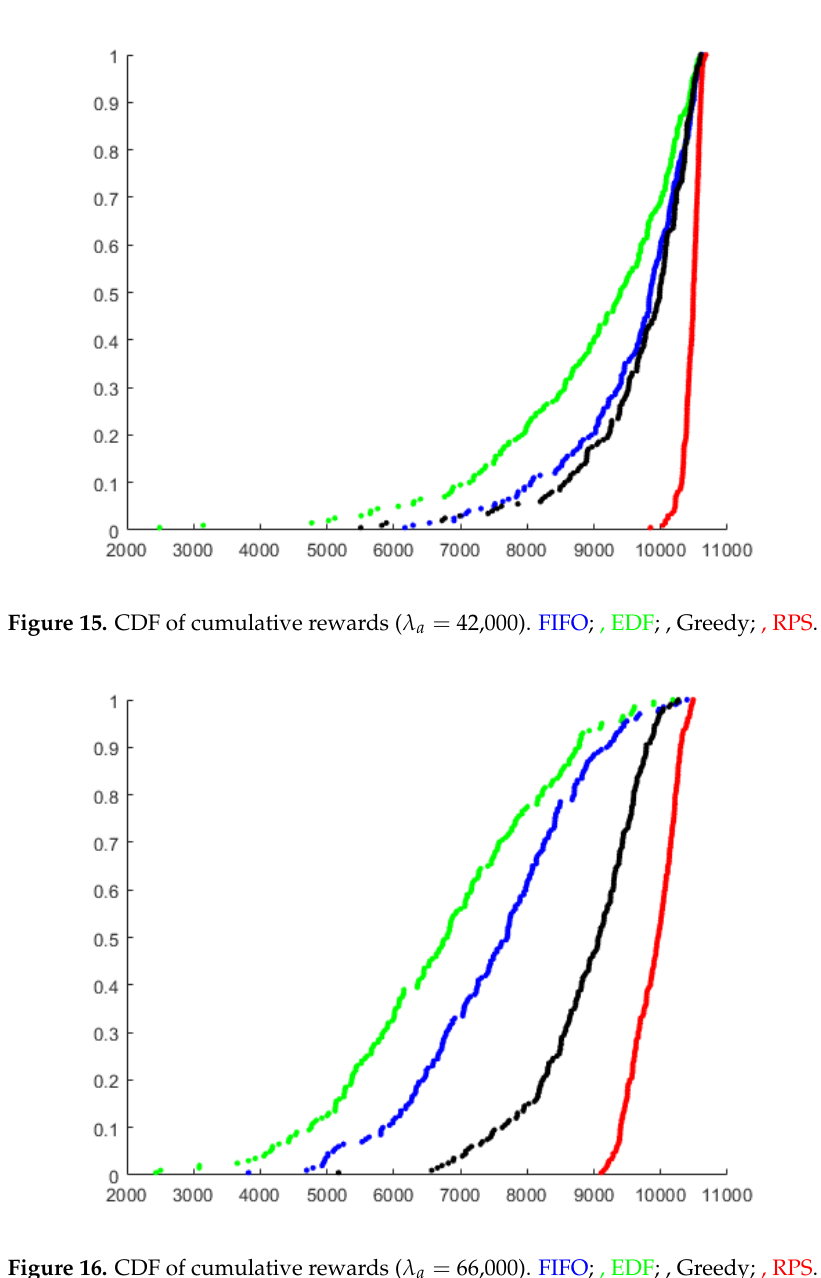
Figure 16. CDF of cumulative rewards ( λ a = 66,000). FIFO; , EDF; , Greedy; ,